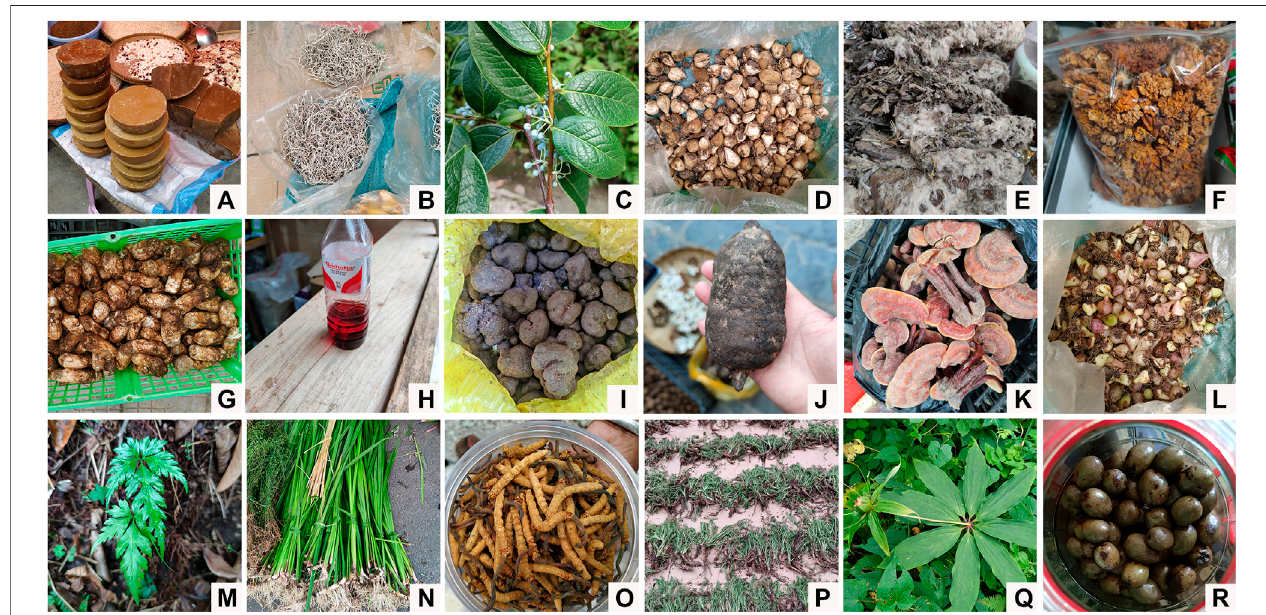
FIGURE 2 | Some medicinal plants with high RFC. (A) The fat extracted from Toxicodendron vernici fl uum ; (B) The whole plant of Thamnolia vermicularia ; (C) The fruit of Vaccinium gaultheriifolium ; (D) The bulb of Fritillaria cirrhosa ; (E) the whole plant of Saussurea obvallata ; (F) The fruit body of Tremella aurantialba ; (G) The fruit body of Tricholoma matsutake ; (H) The fruit body of Hypocrella bambusae ; (I) The fruit body of Tuber melanosporum ; (J) The rhizome of Gastrodia elata ; (K) The fruit body of Ganoderma lucidum ; (L) The rhizome of Bletilla striata ; (M) the whole plant of Coptis teeta ; (N) The whole plant of Acorus calamus ; (O) The fruit body of Ophiocordyceps sinensis ; (P) The whole plant of Tanacetum tatsienense var. tanacetopsis ; (Q) The whole plant of Paris polyphylla var. yunnanensis ; (R) The fruit of Elaeocarpus lacunosus .